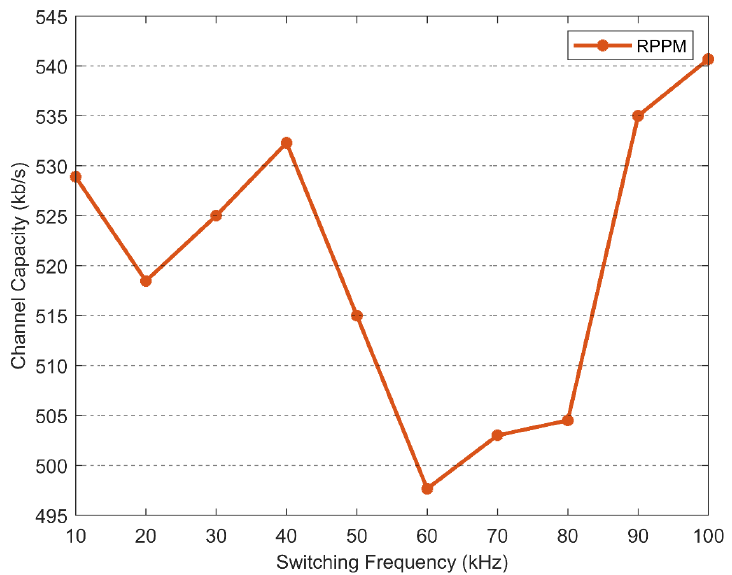
Figure 8. Channel Capacity of the G3 ‐ PLC with different switching frequencies applied to the RPPM modulated DC ‐ DC converter.